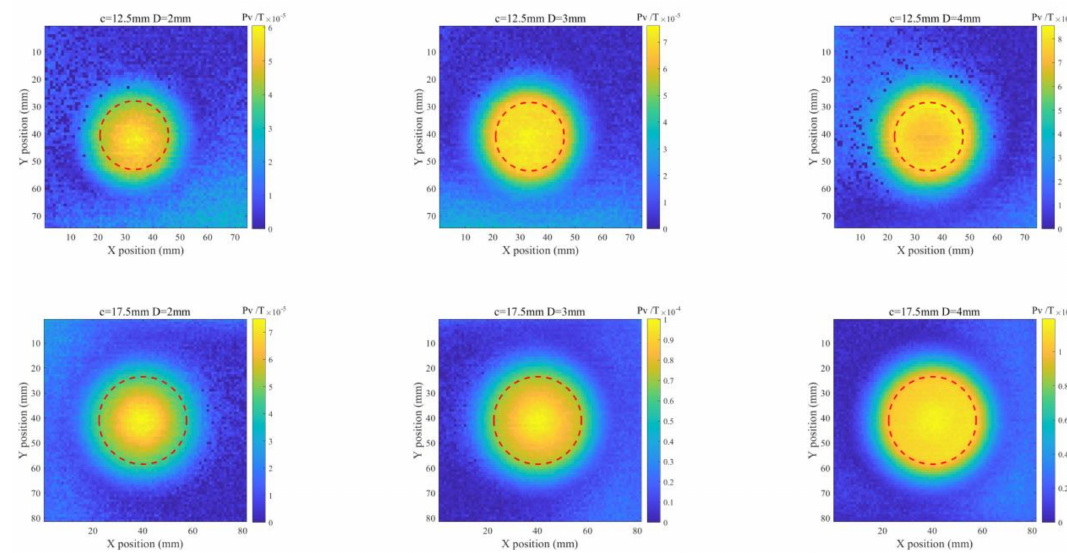
Figure 8. Imaging results for ILC Scenario #1 (where l denotes the length of the square-shaped ILC).